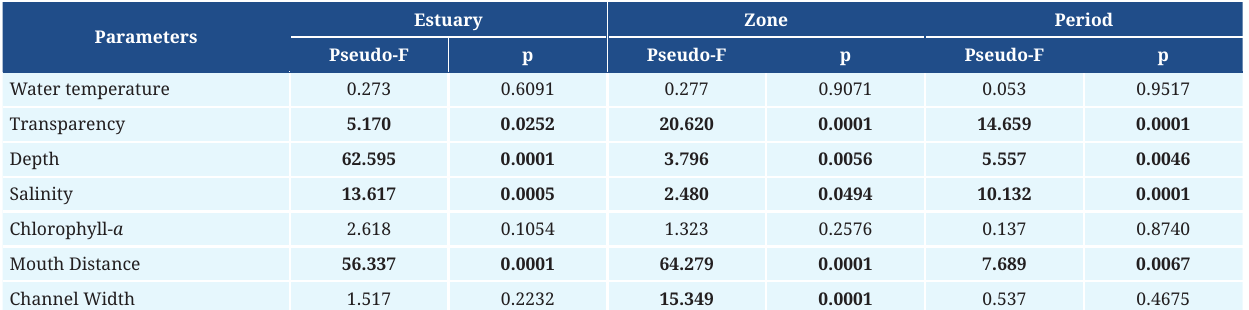
TABLE 2 | PERMANOVA results for water temperature, transparency, depth, salinity and chlorophyll-a between Tubarão and Casqueira river estuaries, as well as in their respective dry and rain periods and their different zones. Significant values in